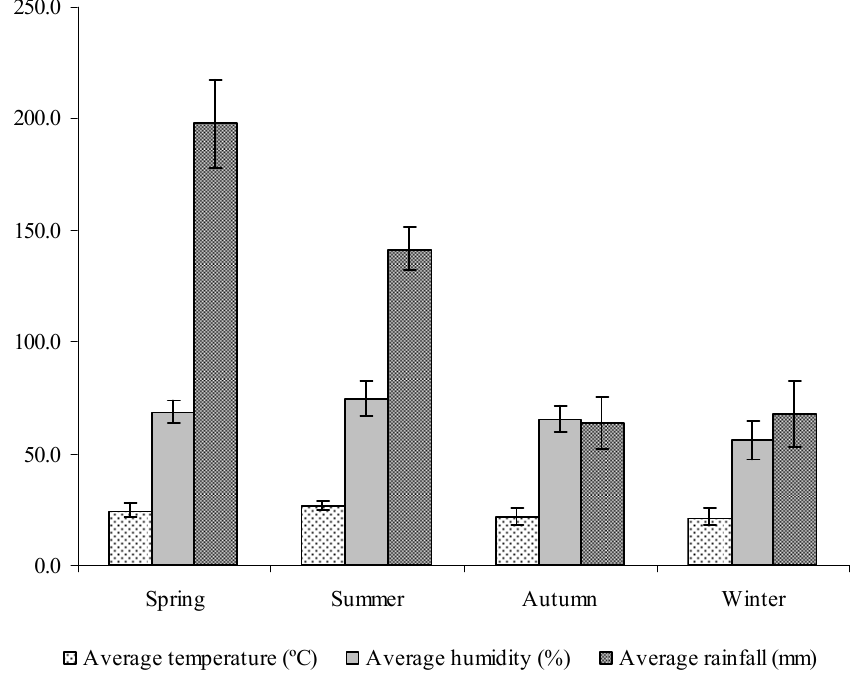
Figure 2. Means and standard deviations of the temperature (°C), rainfall (mm), and relative humidity (%) by season, from September 2006 through August